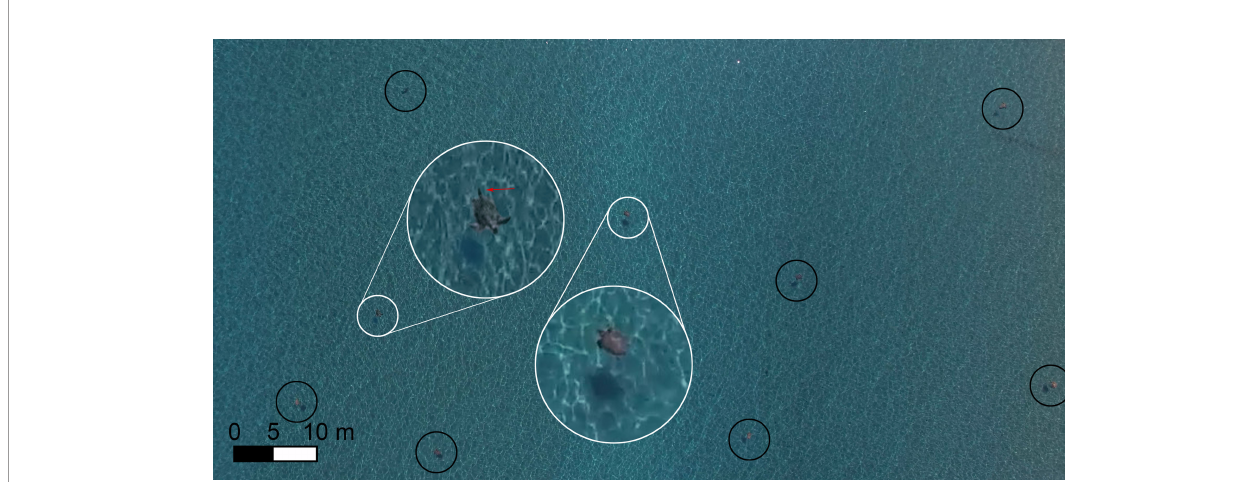
FIGURE 1 | Snapshot from UAS footage at 60 m altitude showing loggerhead sea turtles ( Caretta caretta ) along part of a pre-programmed transect at 0 – 100 m offshore. One male (left) and one female (right) are enlarged (4x, in circles), showing the tail of the male clearly protruding beyond the carapace. Sequential images along part of a path are also presented in Supplementary Figure S3